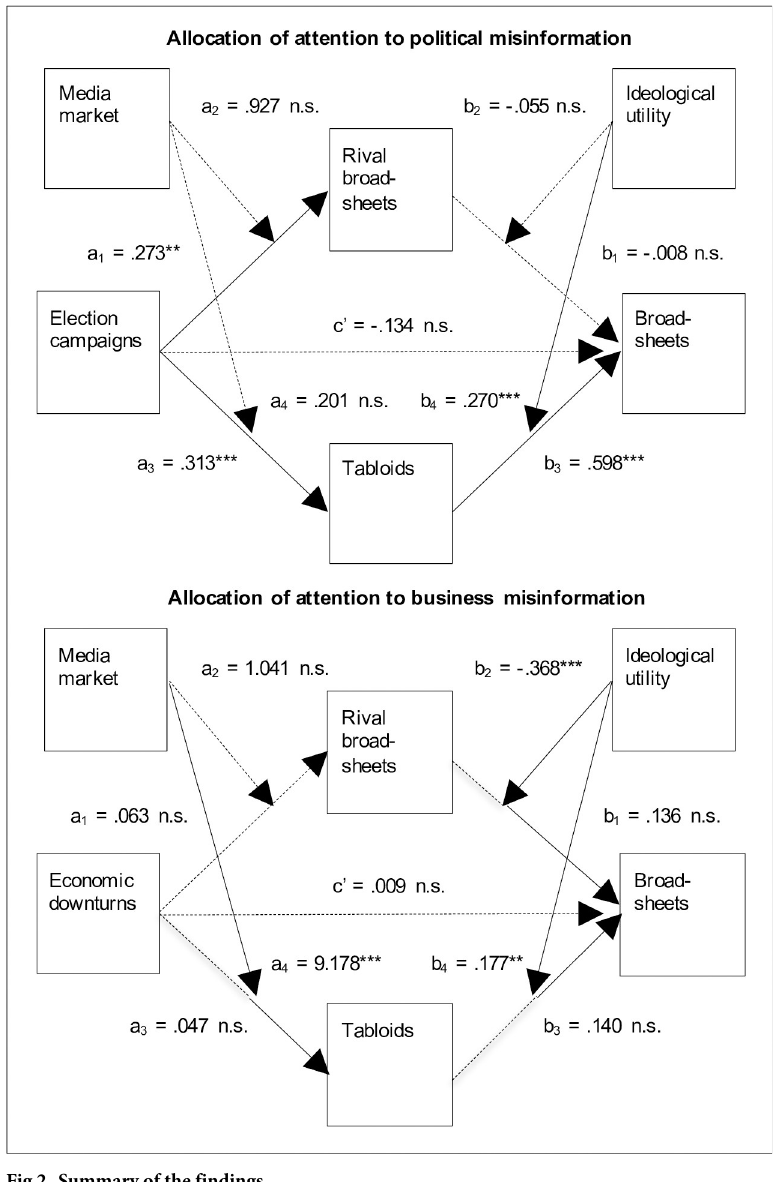
Fig 2. Summary of the